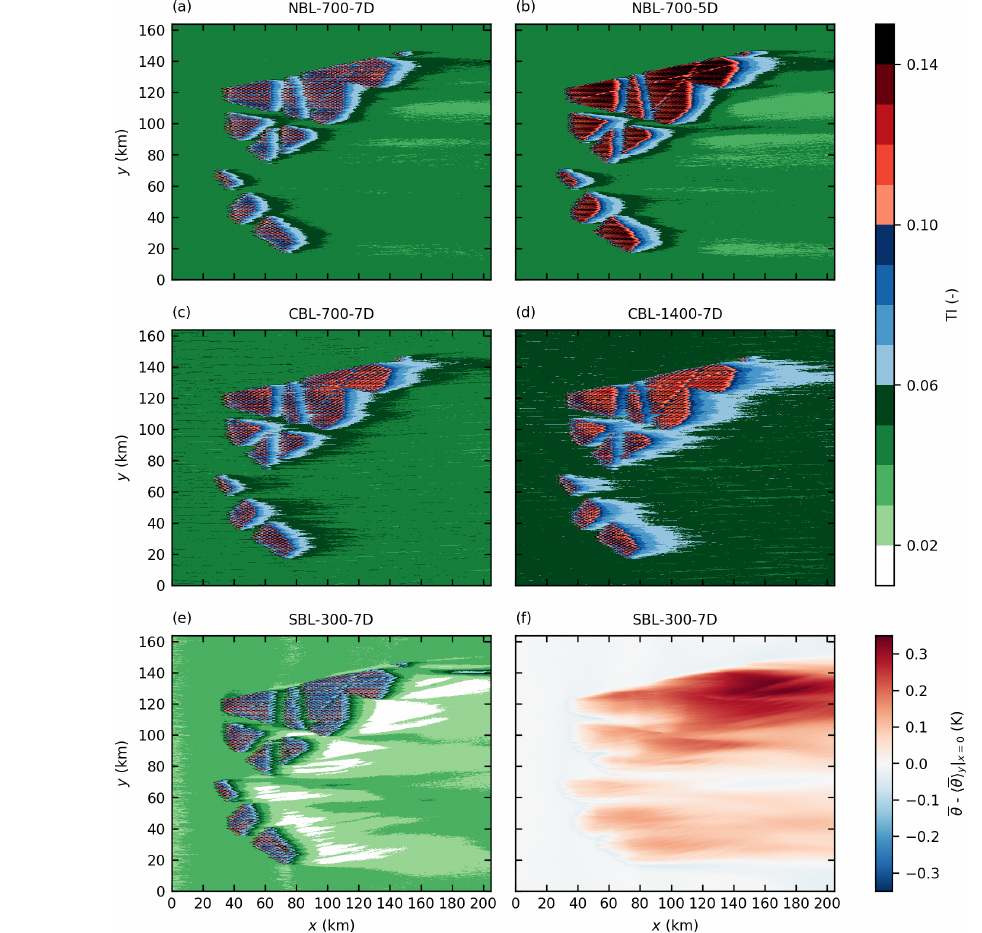
Figure 6. Turbulence intensity (TI) at hub height for all five cases (a–e) and potential temperature at hub height relative to the inflow temperature for the case SBL-300-7D (f)